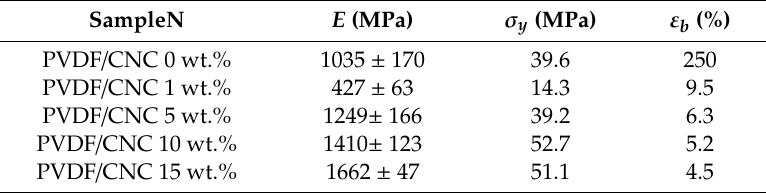
Table 3. Mechanical parameters for the prepared PVDF / CNC